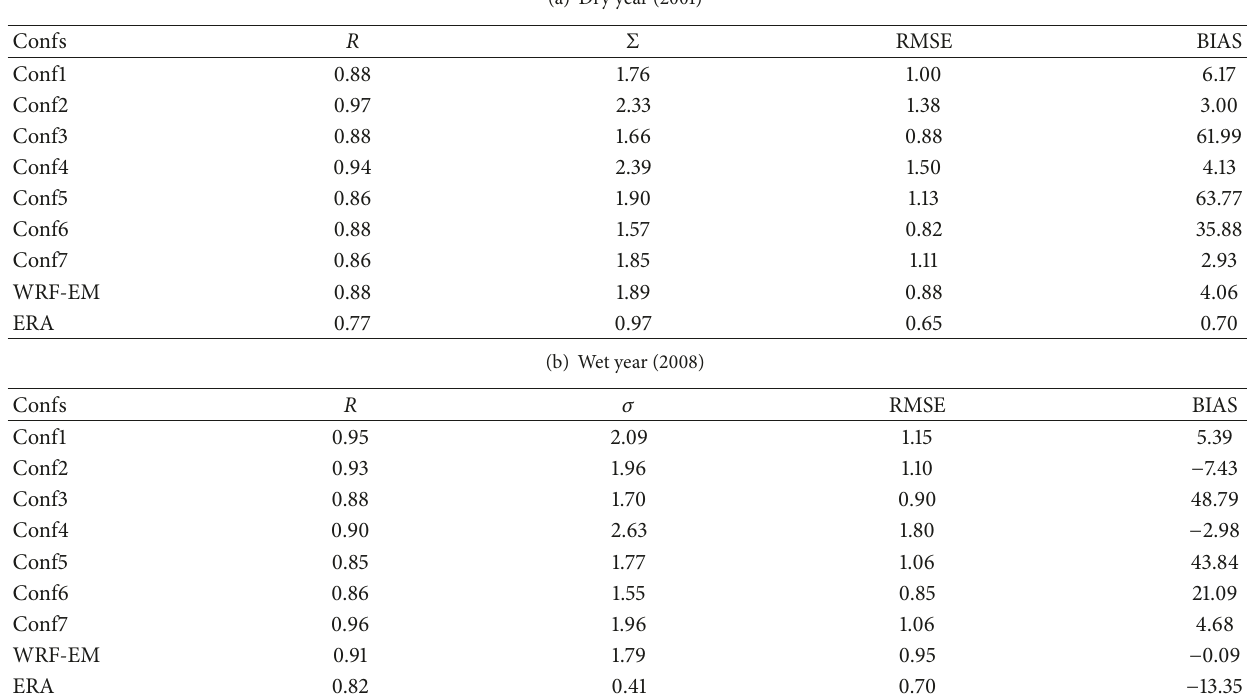
Table 3: The four different statistics, for the whole of Ghana as a unit, for the (a) dry year and (b) wet